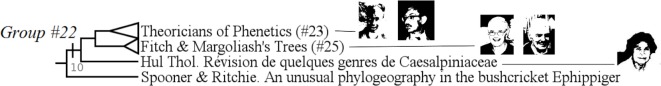
Subtree showing the group #22 (called “Pheneticists”).